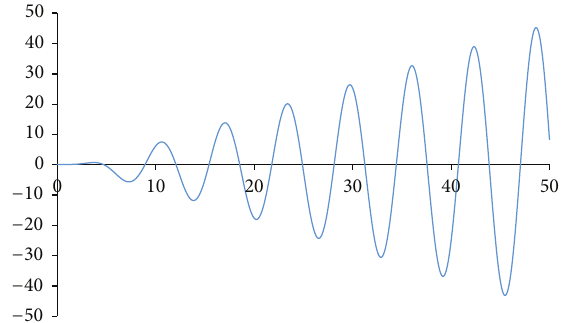
Figure 1: The numerical solution 𝑥(𝑡) for 𝑒(𝑡) = 𝑡 4 sin (𝑡) , 𝛼 = 1/3 and initial conditions 𝑥(0) = 0.1 , 𝑥 󸀠 (0) = 0 .